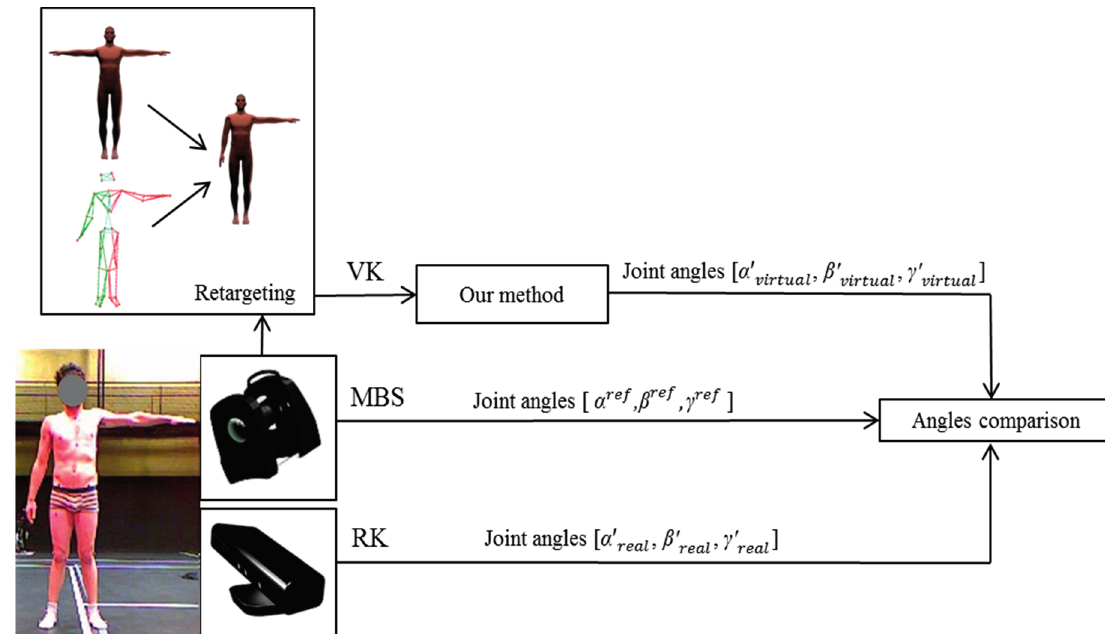
Figure 4. Experimental setup of the comparison of joint angles estimated with an optoelectronic motion capture system (MBS), the corresponding actual Kinect measurements (RK), and the simulated outputs using a virtual mannequin